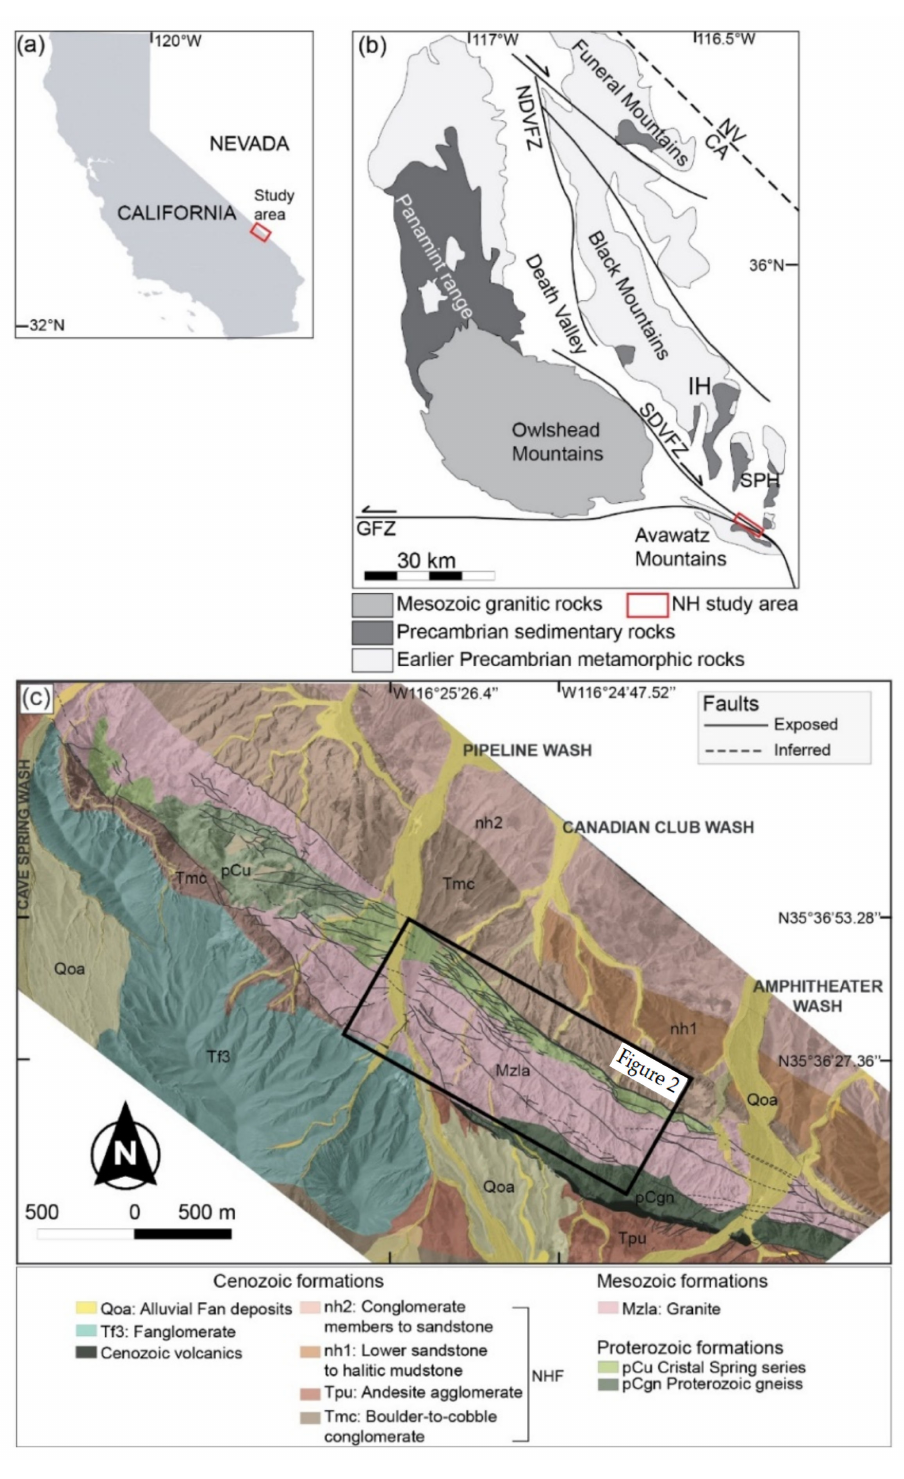
Figure 1. ( a , b ) Location and geological setting of DV and NH studied area modified after [50], NDVFZ: Northern Death Valley Fault Zone, SDVFZ: Southern Death Valley Fault Zone, GFZ: Garlock fault zone, CA: California, NV: Nevada, IH: Ibex Hills, SPH: Saddle Peak Hills. ( c ) Structural scheme of the NH range performed thanks to high-resolution digital mapping techniques (see below) modified after [34,47]. Additional digitized fractures were obtained using orthophotos. NHFs: Noble Hills